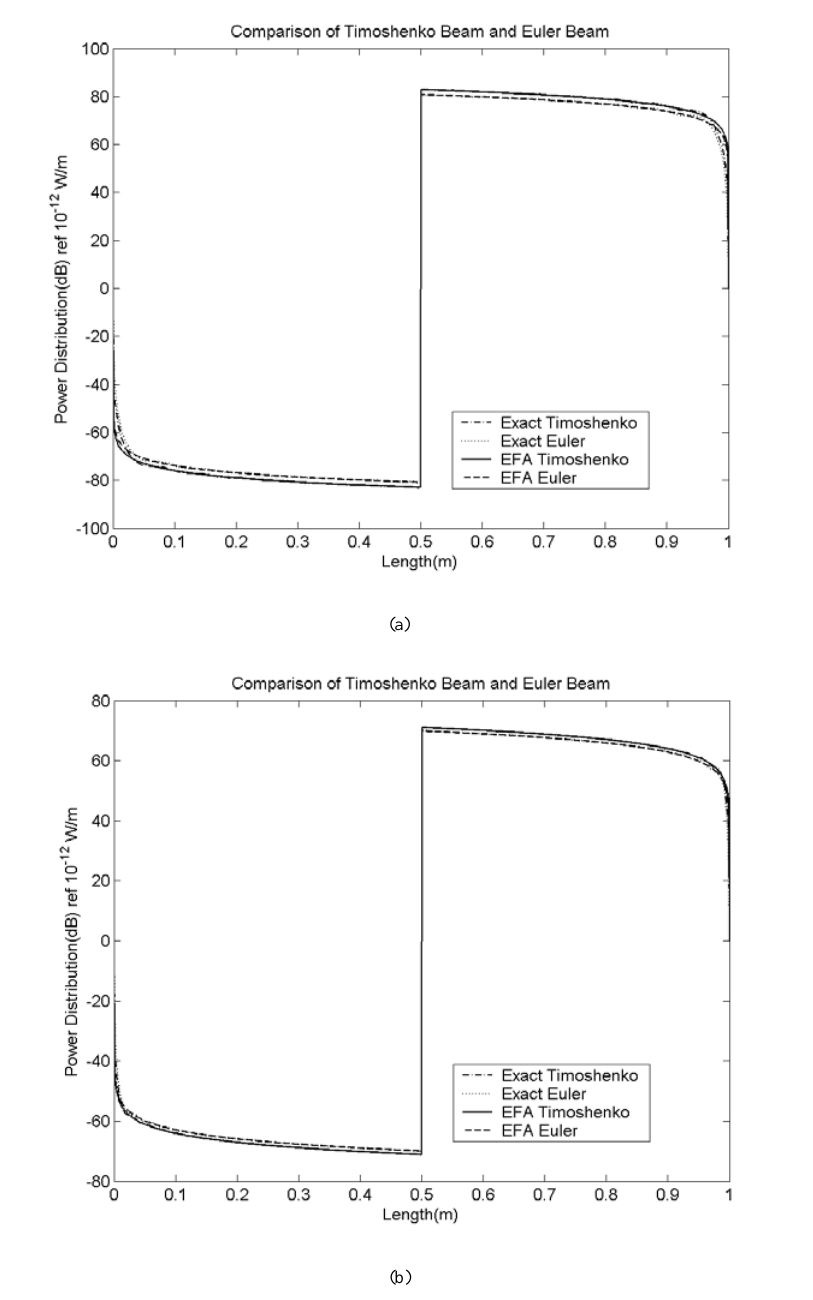
Fig. 7. The power level distributions of the Timoshenko beam ( L / H = 100, f c = 159 kHz) when η = 0.01. The reference power is 10 − 12 W/m: (a) f = 5 kHz, (b) f = 30 kHz, (c) f = 150 kHz, (d) f = 200 kHz: - · - · -, classical solution of the Timoshenko beam; ····· , classical solution of the Euler-Bernoulli beam, —, EFA solution of the Timoshenko beam; ---, EFA solution of the Euler-Bernoulli